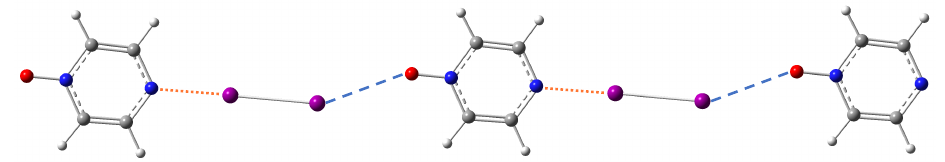
Figure 6. Optimized crystal model structure showing the I · · · O halogen bonding N-1 (blue dashed lines) between diiodine and acceptor molecule N within the infinite alternating chain. The I · · · N halogen bonding is shown with orange dotted lines.